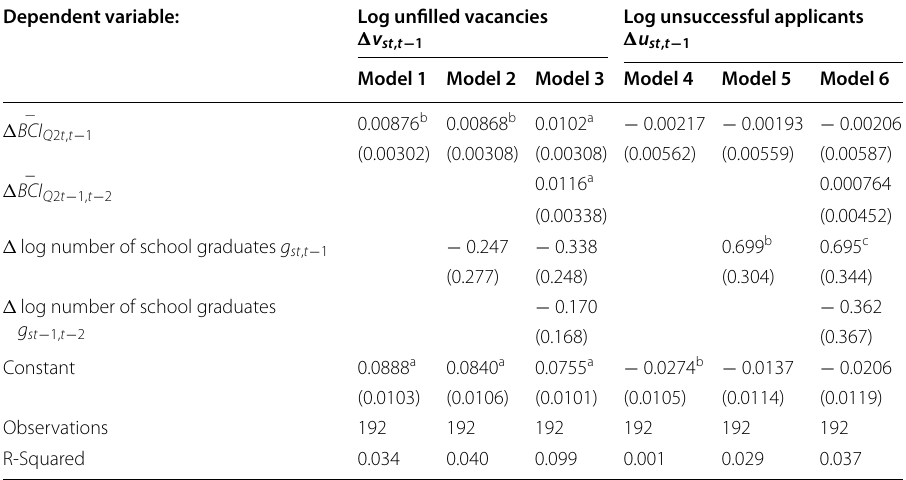
Table 3 First-differences regression, unfilled vacancies and unsuccessful applicants (state- level,